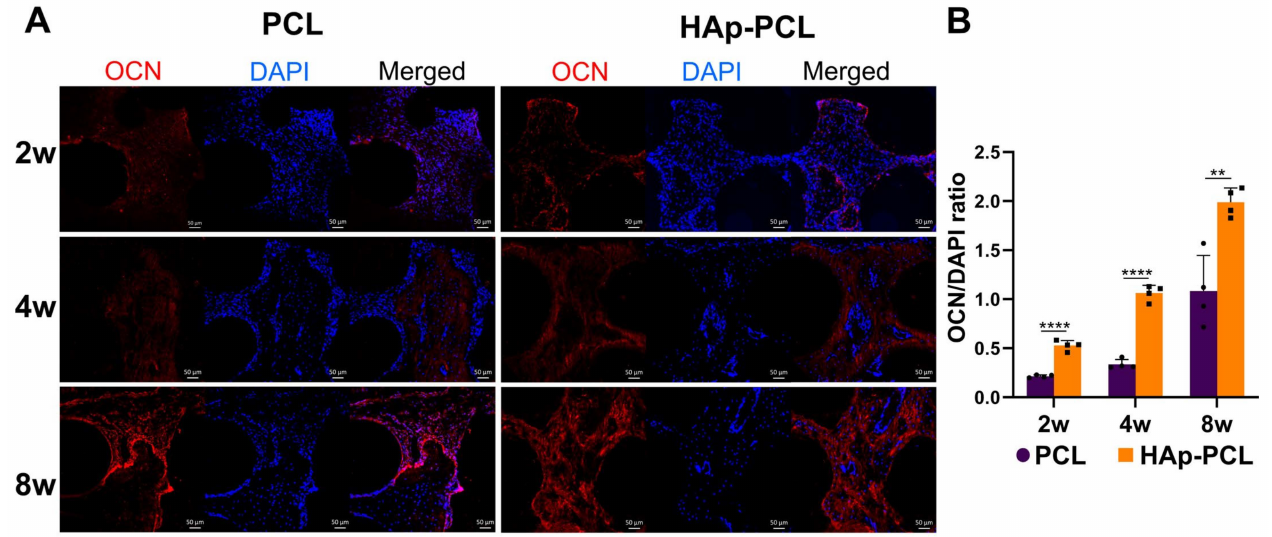
Figure 9. Immunohistochemical staining of cytosolic osteocalcin (OCN, red) for the sectioned tissue inside the scaffold at 2, 4, and 8 weeks after implantation of PCL or HAp-PCL into the critical- sized bone defect in rats. ( A ) Representative staining images. The cell nucleus (blue) was stained with 4’,6-diamidino-2-phenylindole (DAPI). Scale bar is 50 µ m. ( B ) Time profiles in the ratio of osteocalcin-positive area. ** p < 0.01, **** p < 0.0001: significant difference between two groups at the corresponding time.